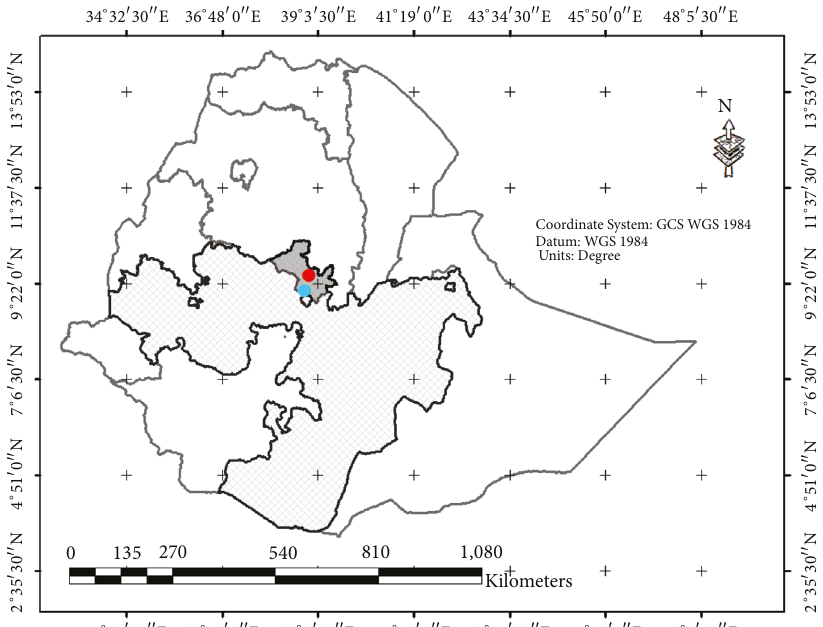
Figure 1: Map of the study